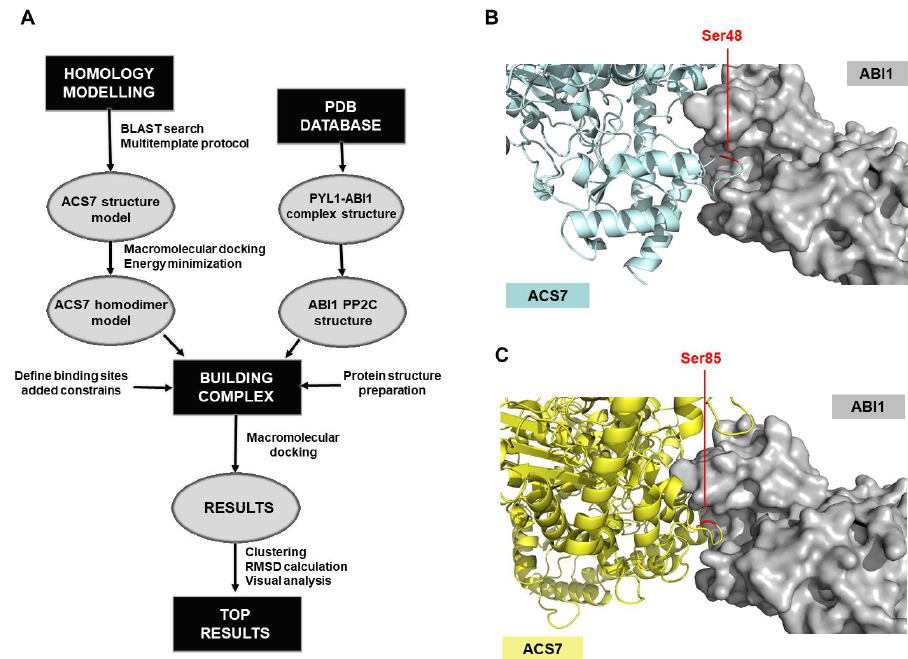
Figure 3. Computational procedure for obtaining the structural model of the ABI1–ACS7 complex.